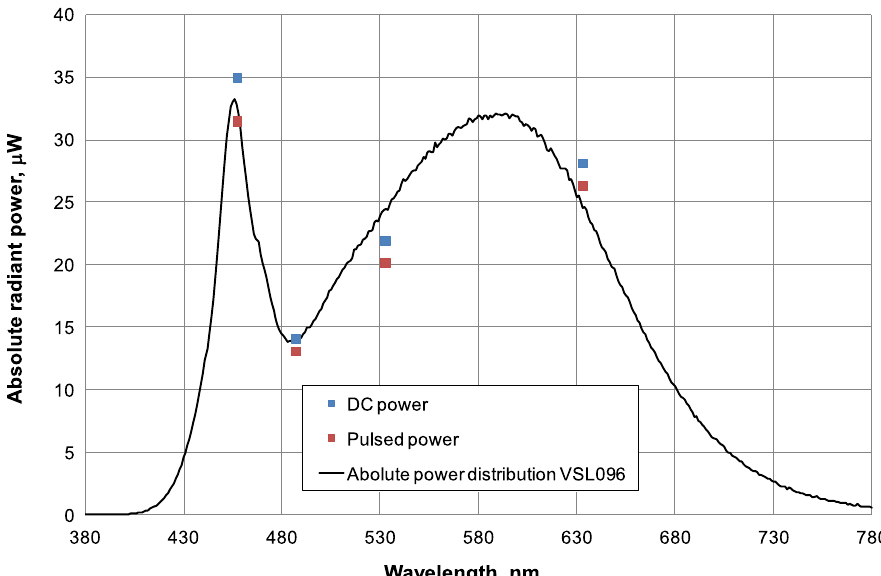
Fig. 12. Resulting absolute power of the short-pulse driven (red) and DC-driven (blue) DUT VSL096 at ODS fi lters wavelengths; the scaled spectral distribution function is given for the reference in black.